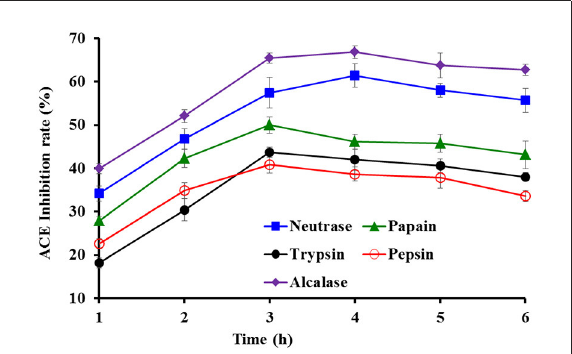
FIGURE1 Effects of protease species and hydrolysis time on ACEi activities of protein hydrolysates from skipjack tuna milts at 2.5